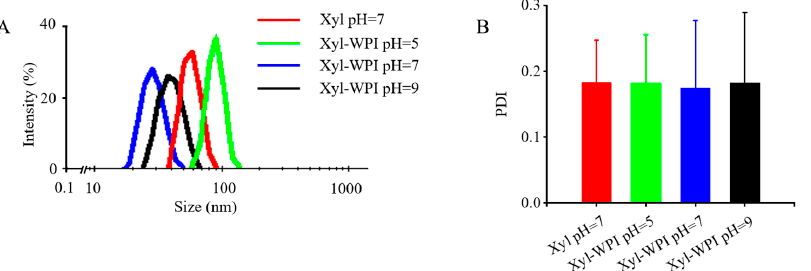
Figure 1. Particle size distribution and PDI value of different W/O emulsions. ( A ) Particle size distribution and ( B ) PDI value. Xyl W/O: Emulsion stabilized by PGPR; Xyl-WPI W/O: Emulsion stabilized by PGPR and WPI; pH refers to the pH value of internal aqueous phase.